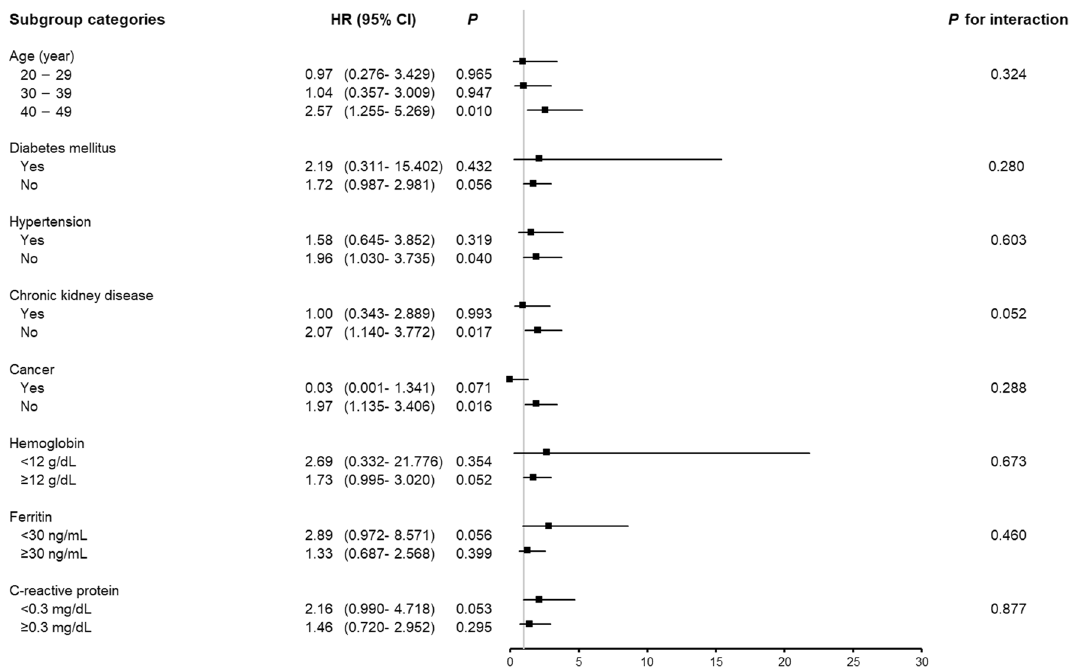
Figure 3. Subgroup association of soluble transferrin receptor with all-cause mortality. The risks for all-cause mortality of the highest tertile (log(sTfR) > 0.57) and the second tertile (log(TfR) 0.45–0.57) are shown. Hazard ratios (HRs) were adjusted for age, race, education, body mass index, haemoglobin, ferritin, C-reactive protein, baseline estimated glomerular filtration rate, random urine albumin-to-creatinine ratio, diabetes mellitus, hypertension, cardiovascular disease, and cancer. HR hazard ratio, CI confidence